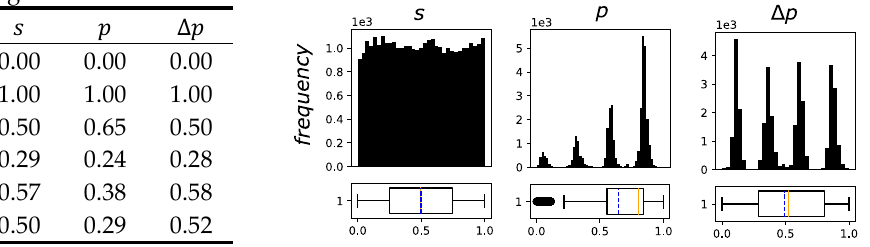
Figure 9. Descriptive statistics of the original training data set (normalized) with ca. 27,000 observations ( left ) and histograms and boxplots of the training data set ( right ).